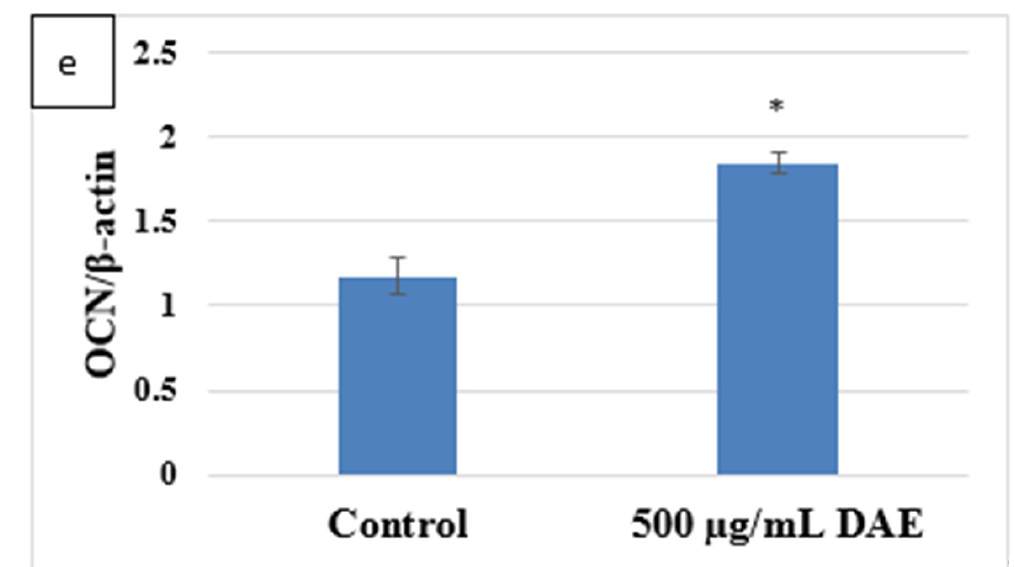
Figure 4. The Alizarin Red S staining ( a ); scale bar = 100 µm and quantification ( b ) of PDLSCs induced with DAE. Quantitative RT-PCR analysis of OCN gene expression ( c ). Western blotting of the OCN protein ( d ) and quantification ( e ). Values are expressed as mean ± SD (n = 3), * p < 0.05 for DAE group compared with control group.